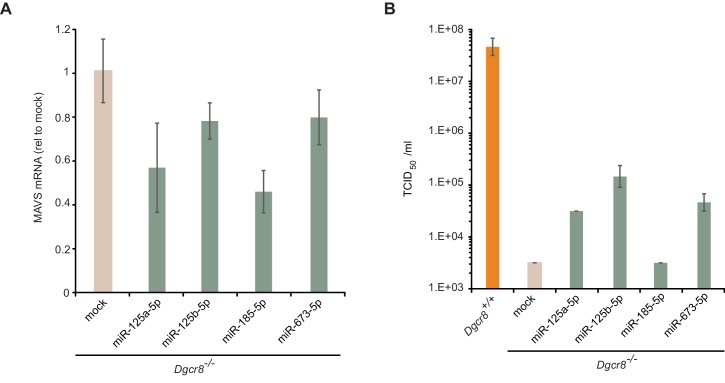
Characterization of MAVS expression in ESCs and regulation by miRNAs.(a) Dgcr8-/- cells were transfected with miRNA mimics for 24 hr, followed by RNA extraction and Mavs mRNA quantification by qRT-PCR. Transfection of all miRNA mimics result in (non-significant) decrease of Mavs levels. (b) Dgcr8-/- mESCs were first transfected with mimics, as in (a) followed by TMEV infections 36 hr later, and measurement of the TCID50. All mimics except for mir-185-5p resulted in higher TCID50 values compared to mock transfected cells, suggesting that in mESC cells targeting Mavs with these miRNAs leads to a higher susceptibility to viral infection.